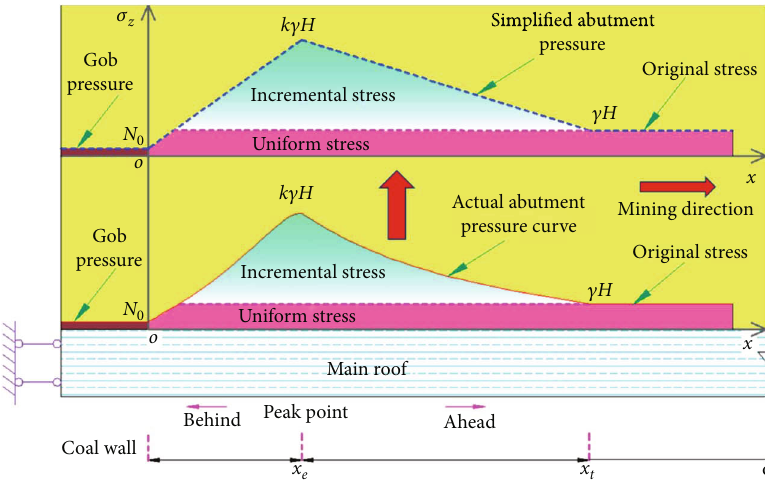
Figure 2: Schematic diagram of roof abutment